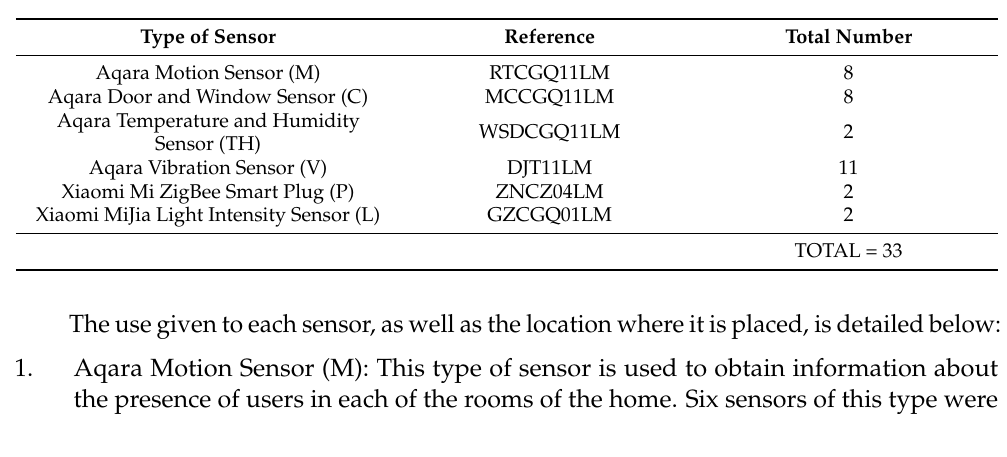
Table 4. Overview of sensors in the installation: types and